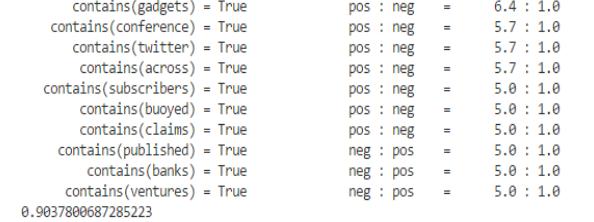
Table 6. Probability calculation for negative class